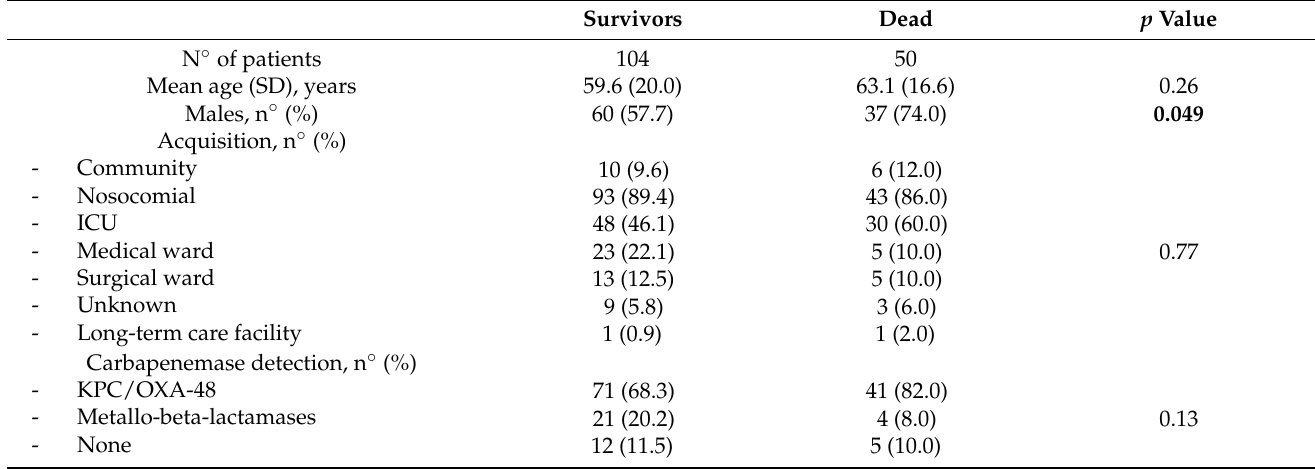
Table 3. Demographic, clinical and microbiological characteristics of patients according to 7-day